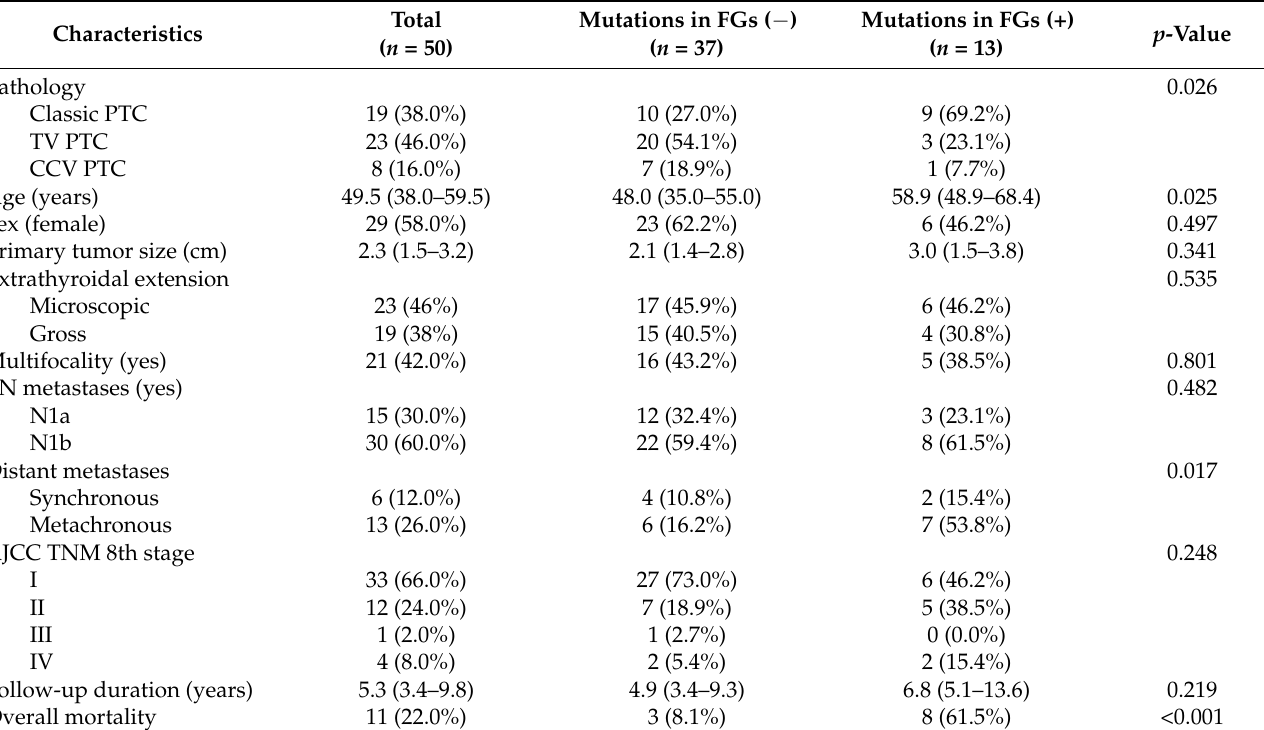
Table 1. Baseline characteristics of patients with advanced PTC harboring the BRAFV600E